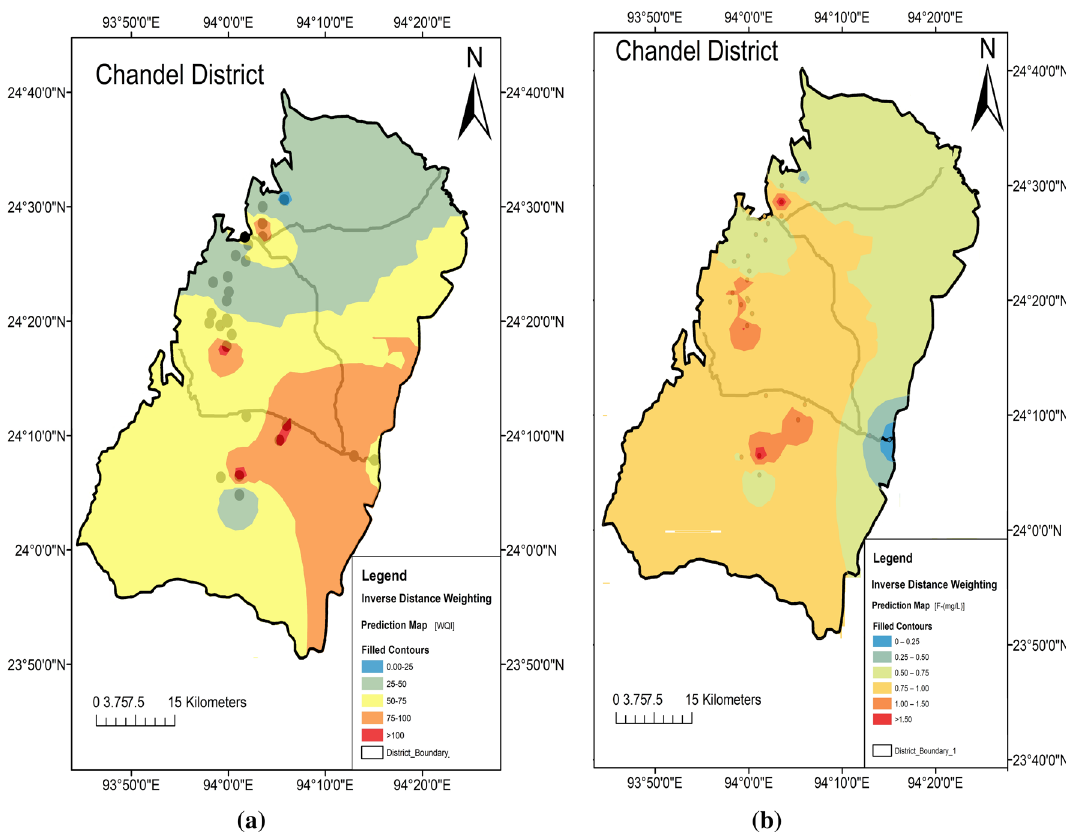
Fig. 3 Predicted geospatial distribution map for a water quality index (WQI) and b fluoride (F − ) concentration, for the study